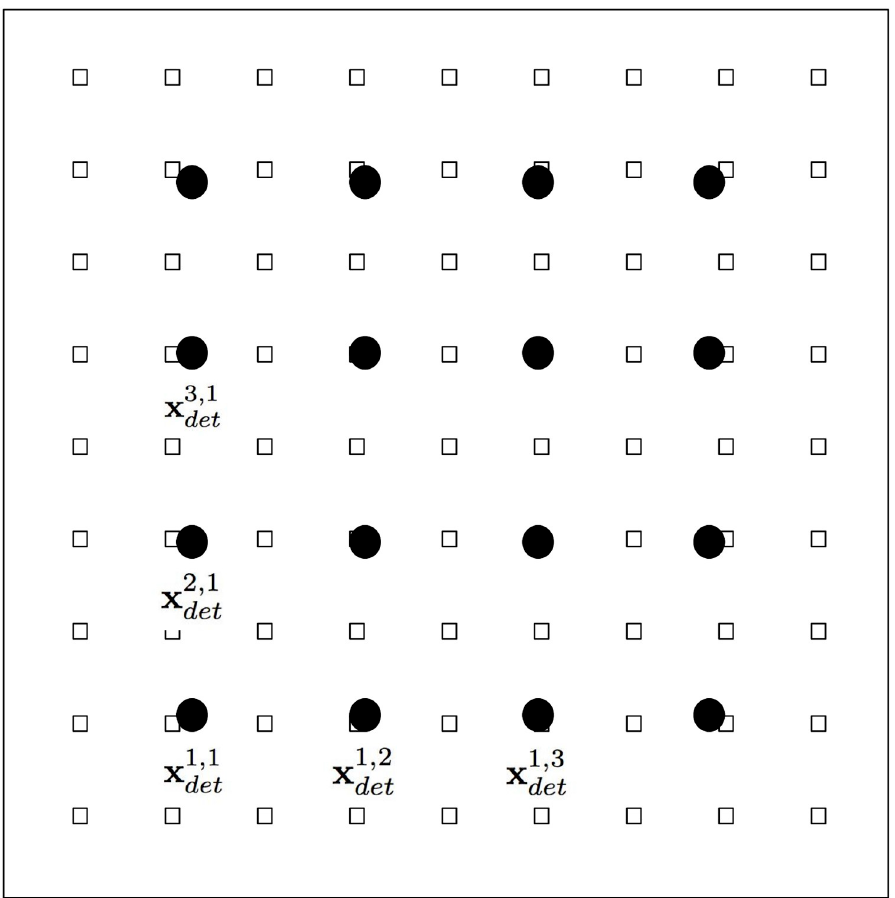
Fig 4. Location of the 81 outbreak positions indicated with small squares and the 16 detectors as filled circles. For illustration, only a few of the detector locations are labeled.